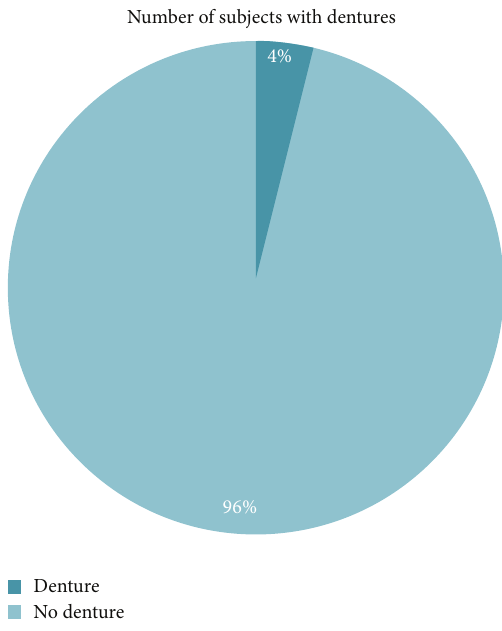
Figure 6: Distribution according to the wearing of dentures. Table 6: Distribution of the study population according to the accessibility factors to oral